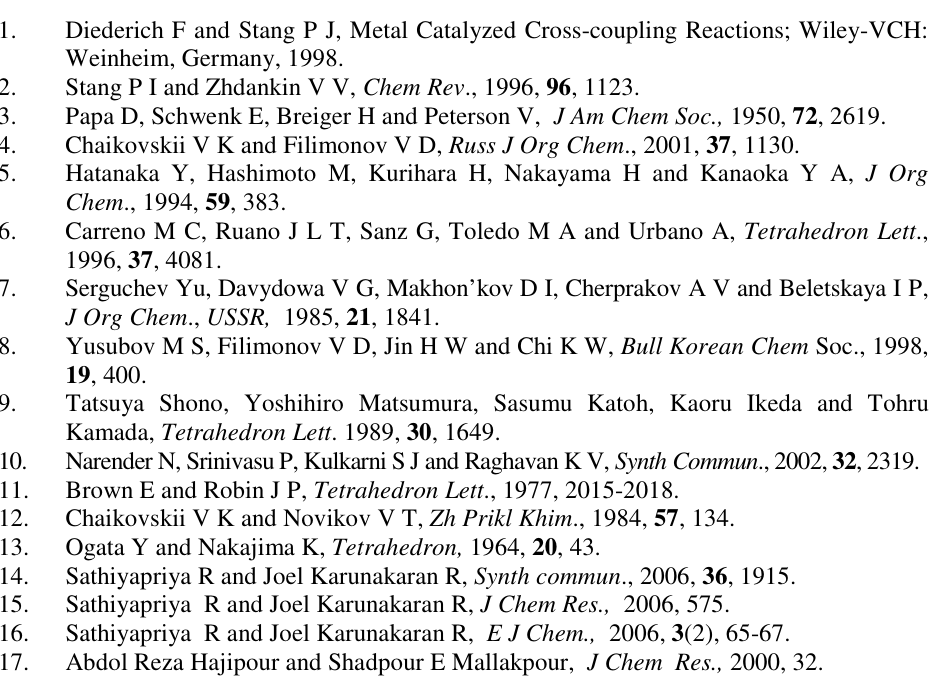
a Products were characterised by m.p or b.p, Mass, 1 H NMR and 13 C NMR. b Isolated